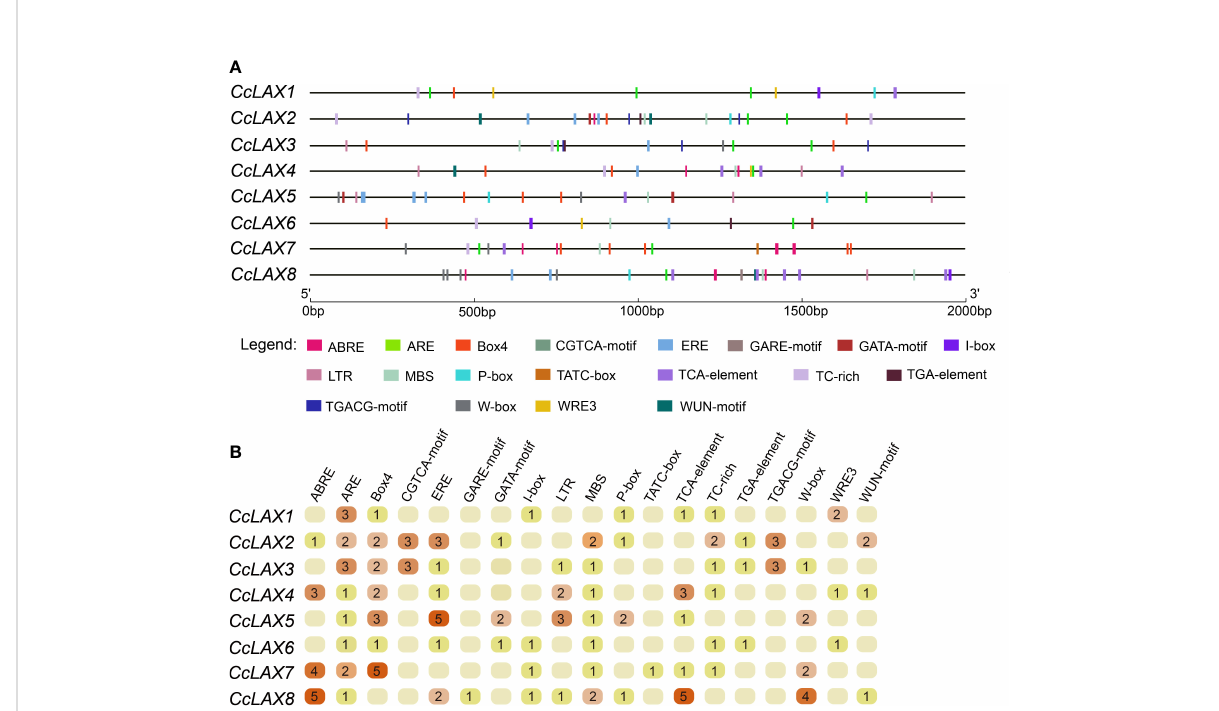
FIGURE 3 The cis -element prediction of CcAUX/LAX promoters. (A) The distribution of the 12 cis -acting elements in the 2000 bp promoter region is shown. The different types of cis -acting elements are represented by different shapes. ABRE, cis -acting element involved in the abscisic acid response. CGTCA-motif, MeJA-response element. ERE motif, cis -acting response involved in the ethylene response. P-box and GARE-motif, elements involved in the gibberellin response. TCA-element, cis -acting element associated with the salicylic acid response. TGA element, cis - acting element involved in the auxin response. CCAAT-box, abiotic stress response elements. LTR, cis -acting element involved in the low temperature response, MBS, MYB binding site involved in drought-inducibility. TC-rich, involved in defense and abiotic stress. W-box, WRKY binding site. (B) Number of cis-acting elements on the promoters of different